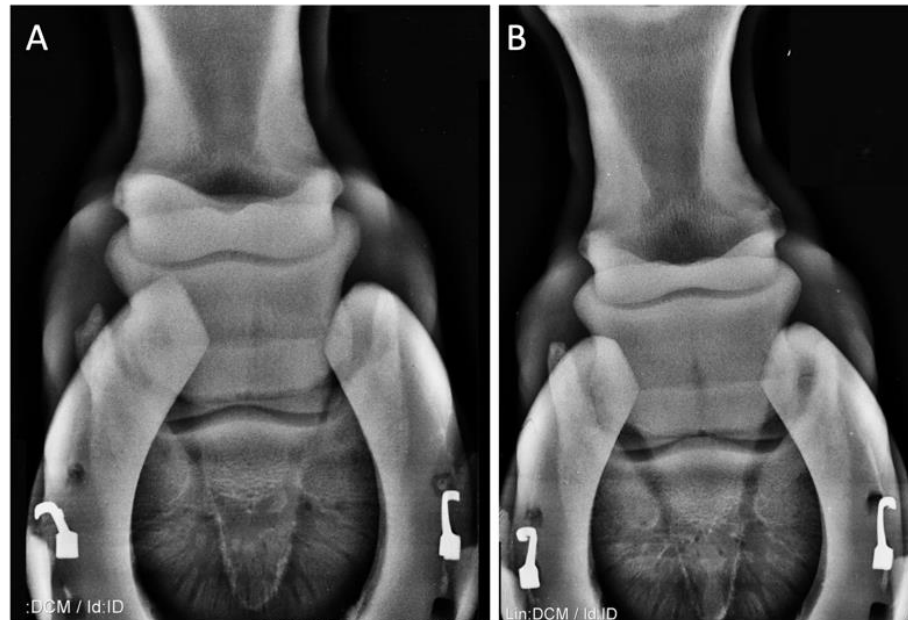
Figure 1. Case 1: A gelding 7-year-old jumping horse. X-ray of left ( A ) and right ( B ) forelimb. Panel A shows slight alterations in the silhouette of the navicular bone.